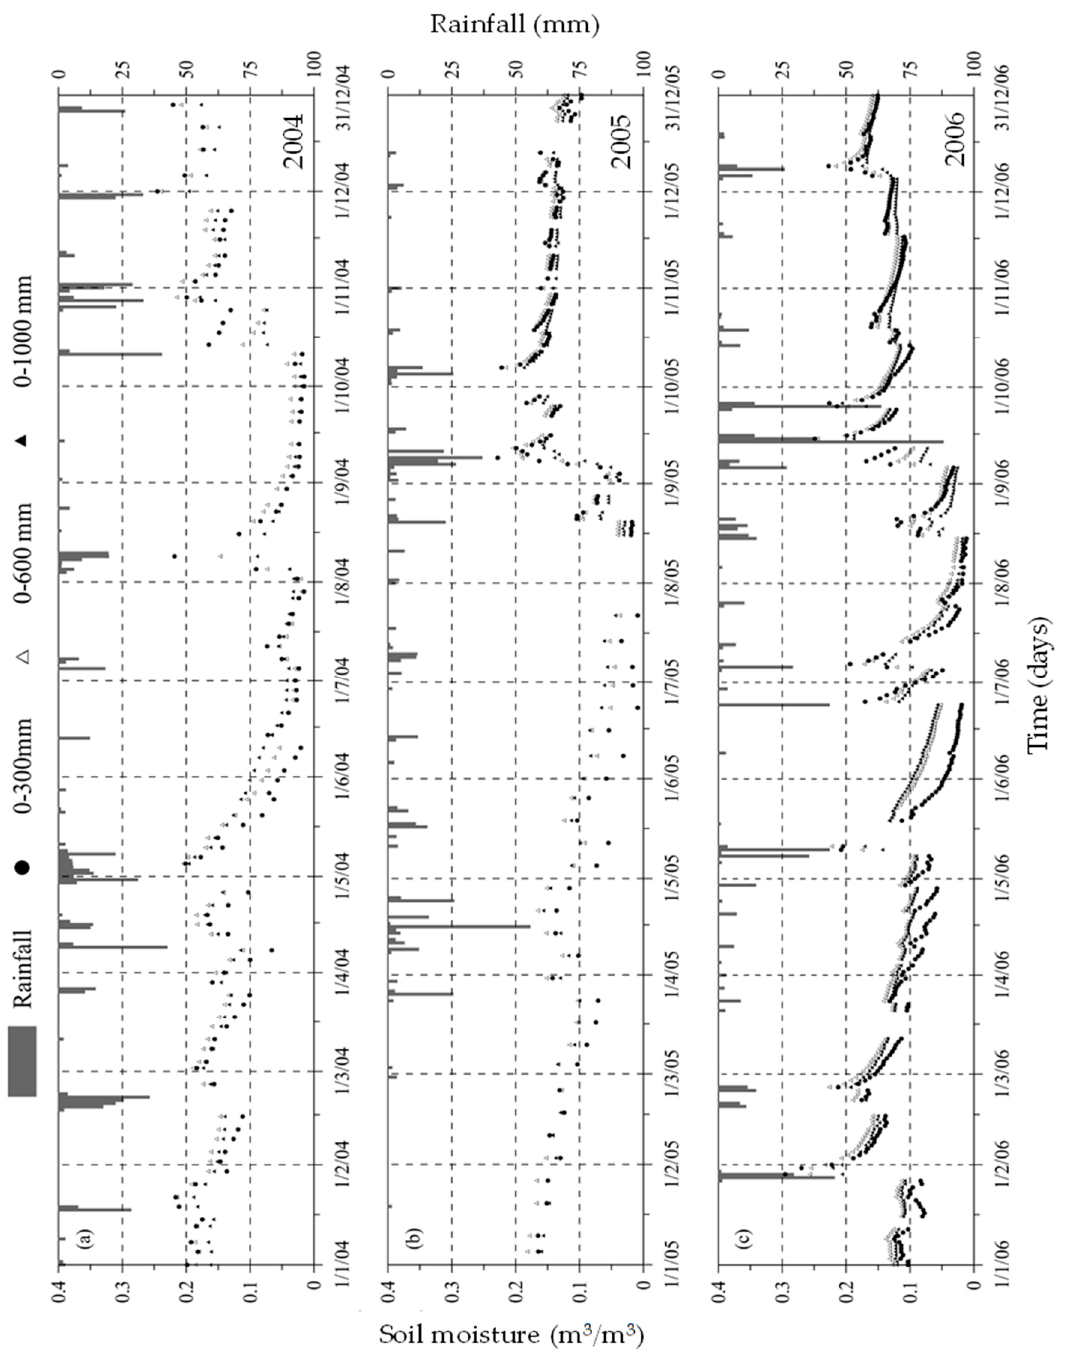
Figure 7. Grugliasco site, 2004–2006. Daily soil water content and rainfall data within the layers 0–0.3, 0–0.6, and 0–1.0 m from 1 January 2004 to 31 December 2006. Since 2005 data have been automatically sampled at hourly step intervals.